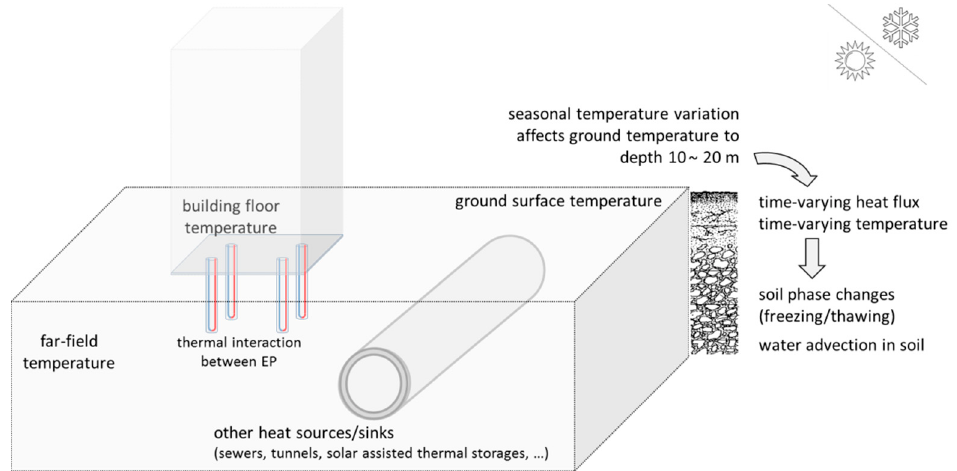
Figure 2. EP boundary conditions and heat transfer as a case of SGES.